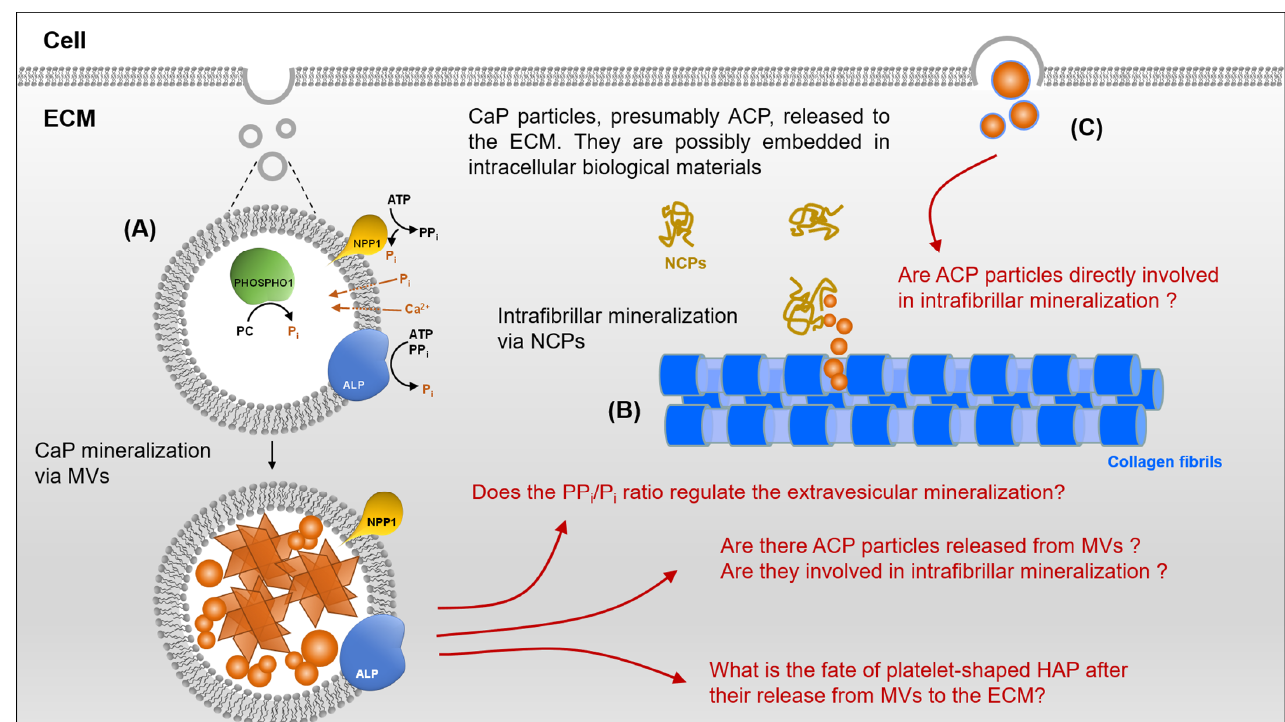
Figure 2. Schematic presentation depicting the “grey areas” regarding the biogenic formation of CaP mineral in the extra- cellular matrix (ECM). ( A ) Mineralization initiated by matrix vesicles (MVs) by (i) the enzymatic generation of Pi, (ii) the regulation of their P i /PP i ratio, (iii) intravesicular accumulation of P i and Ca 2+ and (iv) formation of ACP mineral (spheroid particles) that crystallize to form HAP platelets. The mechanism of transport of CaP ion precursors, P i and Ca 2+ , indicated by arrows and dashed lines, involves phosphate transporters [101] and annexins [102], respectively, which are not shown. ( B ) Intrafibrillar mineralization mediated by non-collagenous proteins (NCPs). ( C ) Release of presumable ACP particles from the cytosol to the ECM.